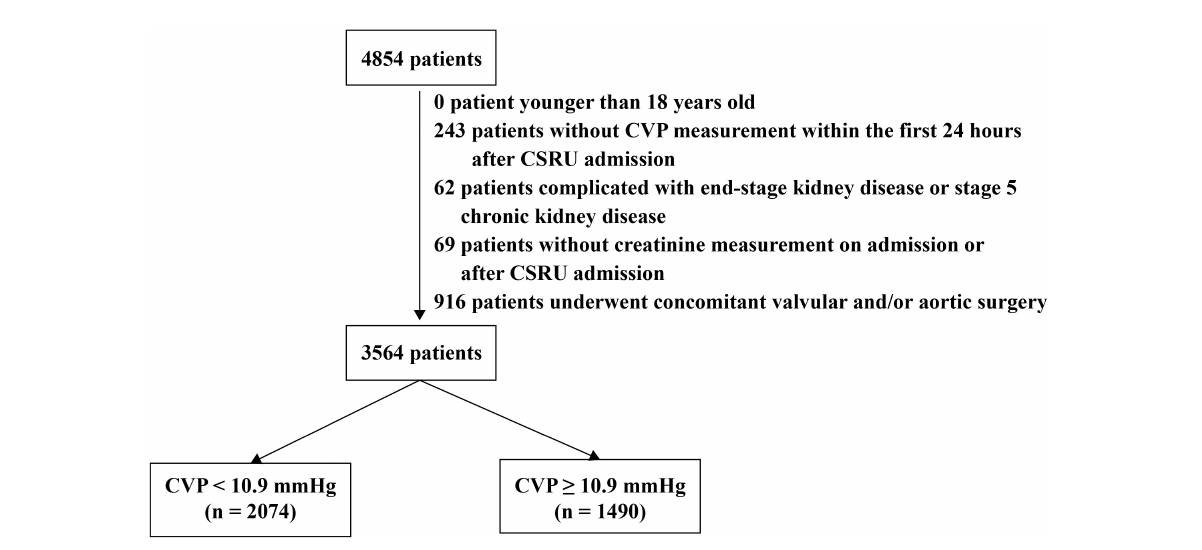
FIGURE1 The flow diagram of patient selection. Patients were divided into two groups according to the results of receiver operating characteristic curves. CSRU: Cardiac surgery recovery unit. CVP: Central venous